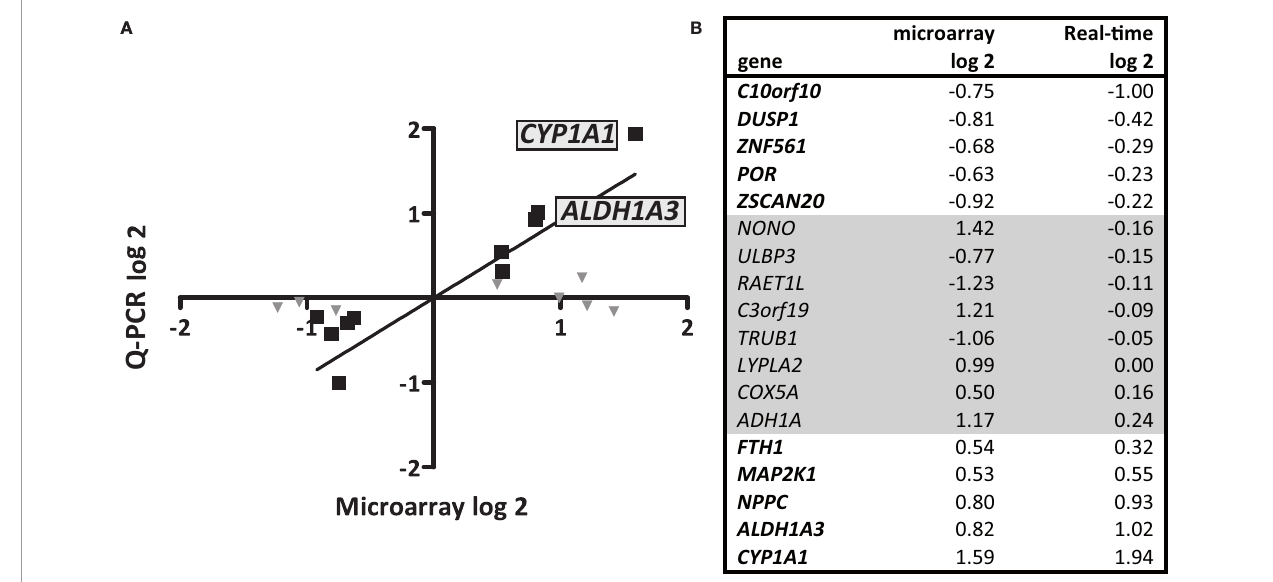
FIGURE 1 | Microarray data and validation. Microarray analysis was performed to pro fi le S. gallolyticus UCN34-induced pathways that could be involved in CRC. (A) The upregulation of 18 selected genes was validated by quantitative real-time PCR (qPCR) analysis. The positions of the most signi fi cantly upregulated genes CYP1A1 and ALDH1A3 are indicated. (B) The corresponding log 2 values of microarray and qPCR are listed for each gene. The 10 genes that showed similar effects in microarray and qPCR [Pearson correlation (r = 0.94; p < 0.001)] are (B) printed in bold and (A) marked by black squares. Gene expression changes that could not be validated by qPCR are (B) printed in gray and (A) marked by gray